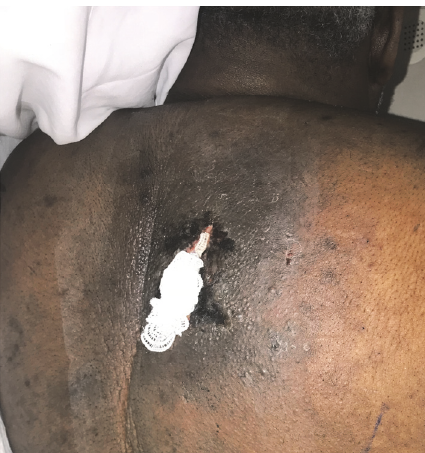
Figure 1: Upper back demonstrating thickened skin after incision and drainage.